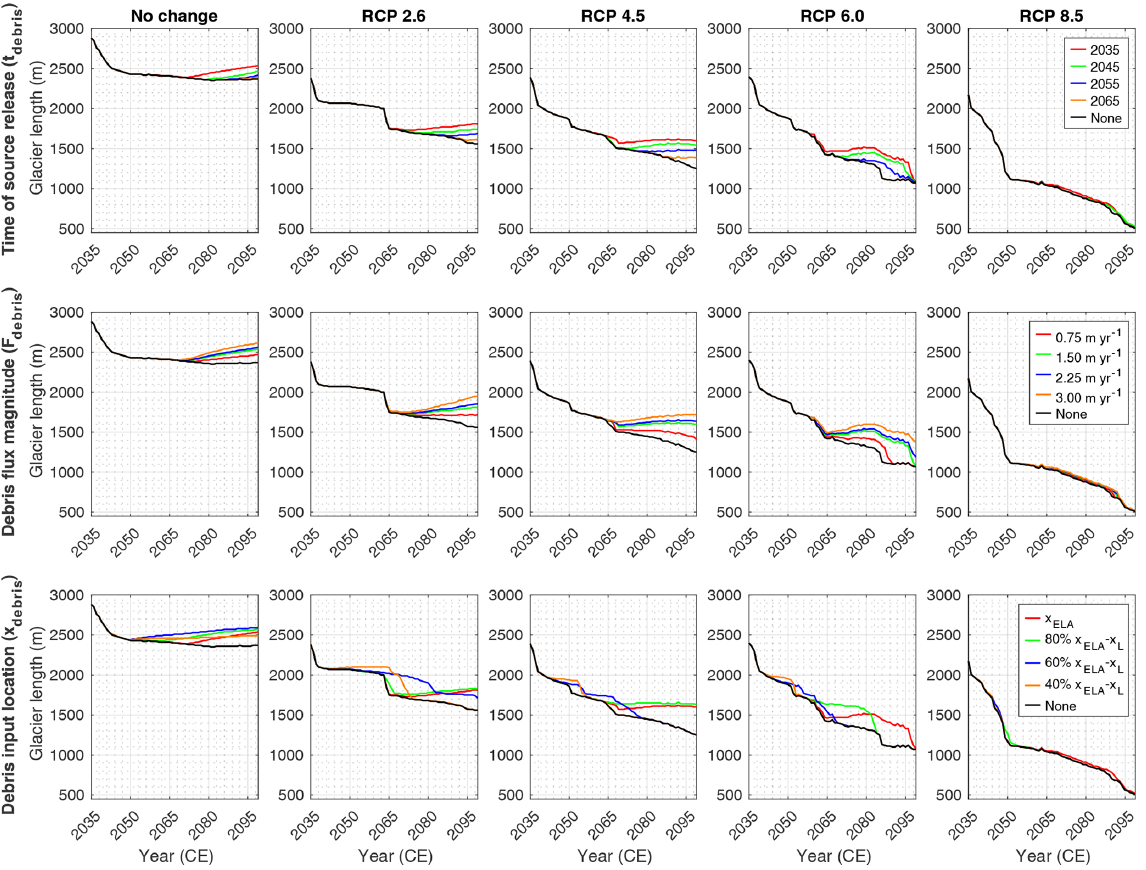
Figure 12. Impact of debris input location x debris , time of release of the debris source t debris and debris flux magnitude F input future length evolution of the Djankuat Glacier under different climatic scenarios (columns) after